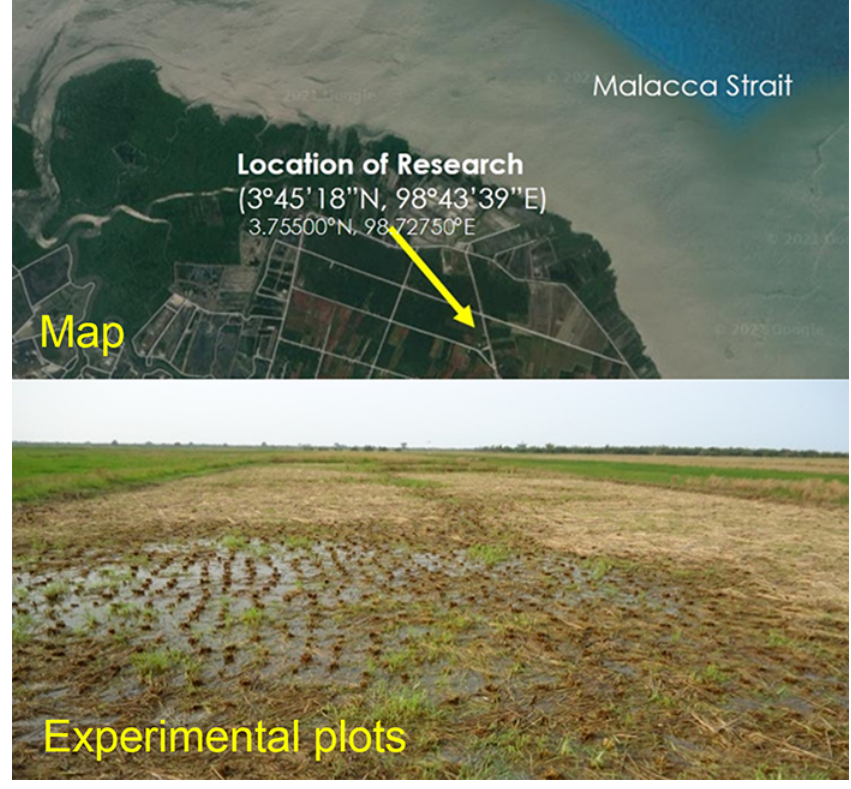
Figure 1 Map of the location and appearance of the experimental